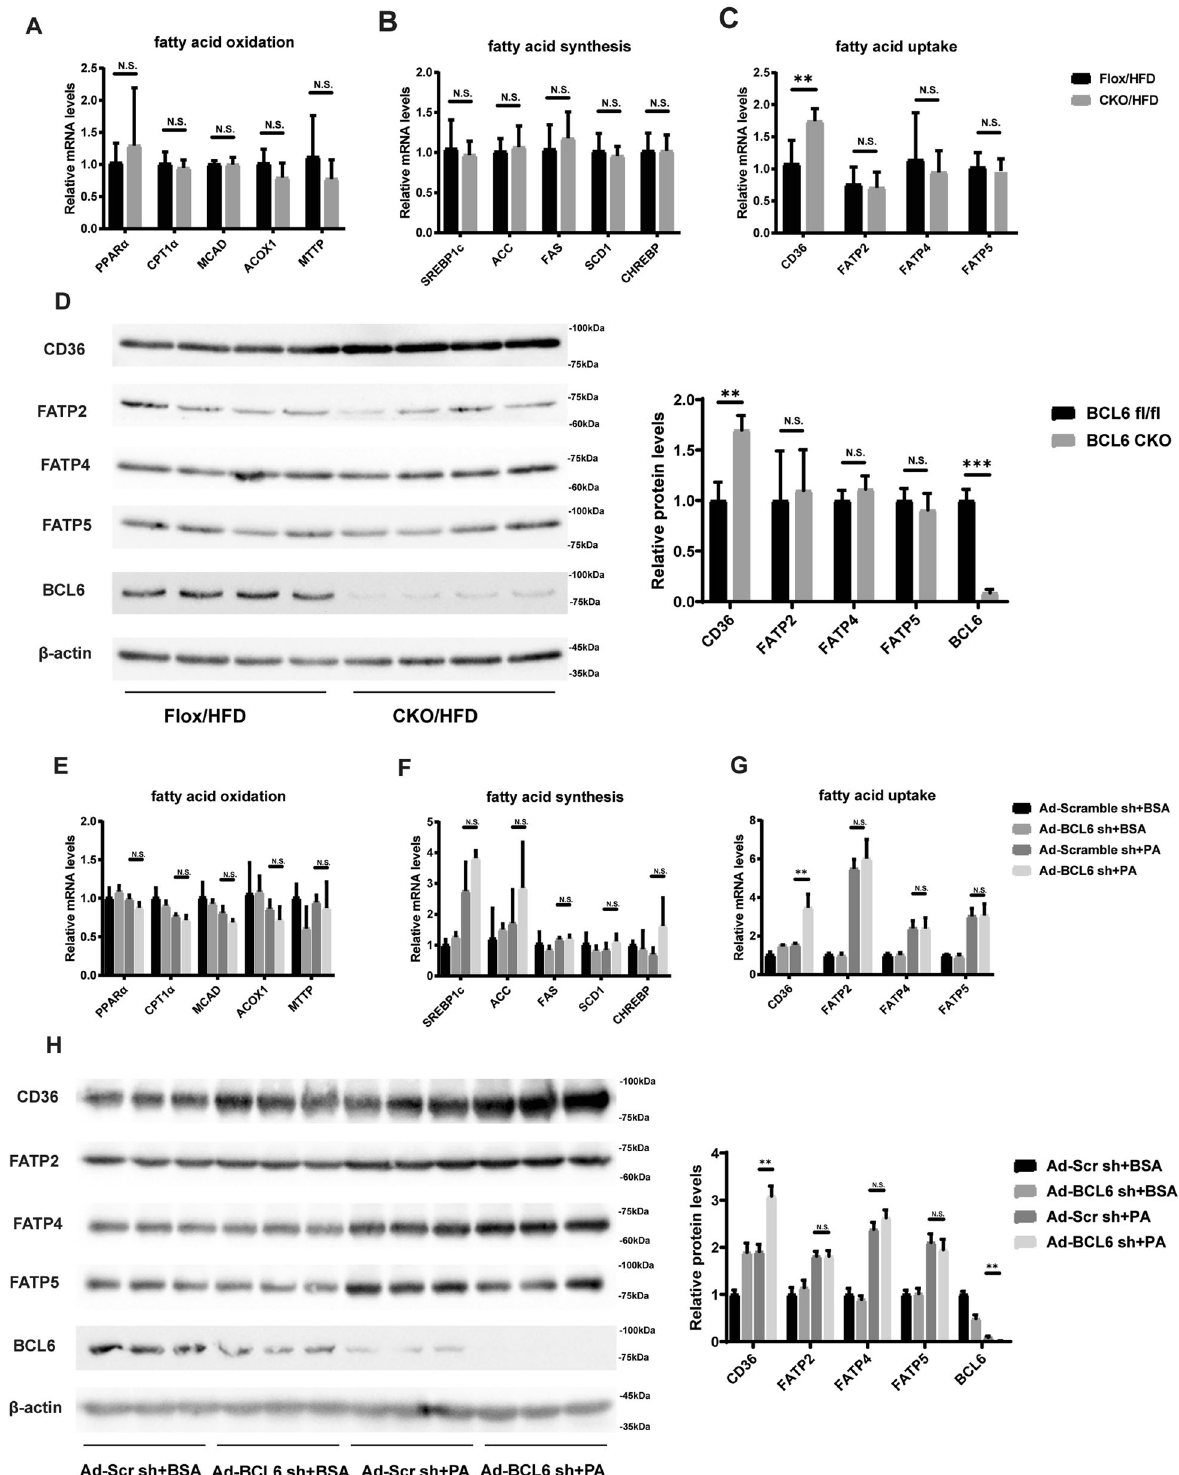
Fig. 6 BCL6 knockout promotes CD36 expression both in vivo and in vitro. Relative mRNA levels of genes related to ( A ) FFA oxidation, ( B ) synthesis, and ( C ) uptake in the livers of BCL6- fl ox and BCL6-CKO mice fed an HFD for 16 weeks. D Protein level of BCL6 and genes related to FFA uptake in the livers of mice. Relative mRNA levels of gene related to ( E ) FFA oxidation, ( F ) synthesis, and ( G ) uptake in the LO2 cells stimulated with PA (0.3 mM) for 24 h after transfected with Ad-Scr sh (as a control) or Ad-BCL6 sh for 48 h. n = 3 in each group. H Protein level of BCL6 and genes related to FFA uptake in the LO2 cells. Data represent the mean ± SEM, * P < 0.05, ** P < 0.01, *** P < 0.001 and n.s. indicates no signi fi cance between the two indicated groups.